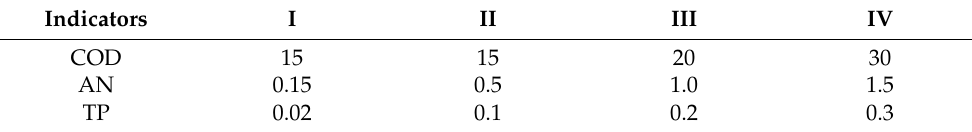
Table 9. Standards values of surface water environmental quality (GB3838-2002) (unit: mg/L).